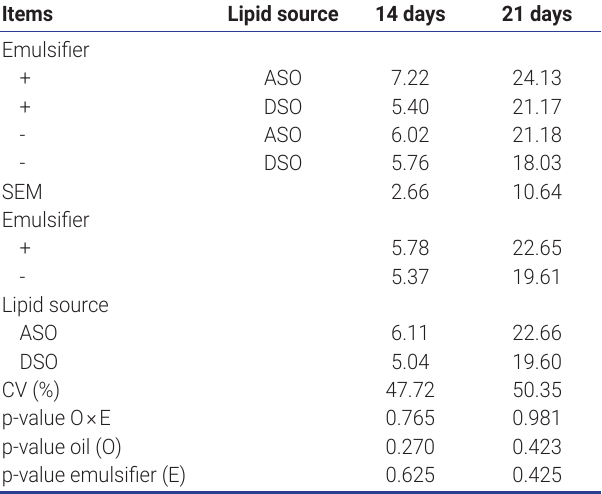
Table 6. Lipase activity (UI/mg of protein) in pancreas of broilers fed diets containing different lipid sources, with or without emulsifier